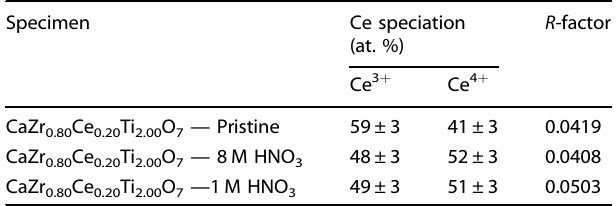
Table 2. Ce speciation (at.%) in CaZr 0.80 Ce 0.20 Ti 2.00 O 7 determined by linear combination fi tting of Ce L 3 XANES data with respect to Ce 3 + and Ce 4 + reference